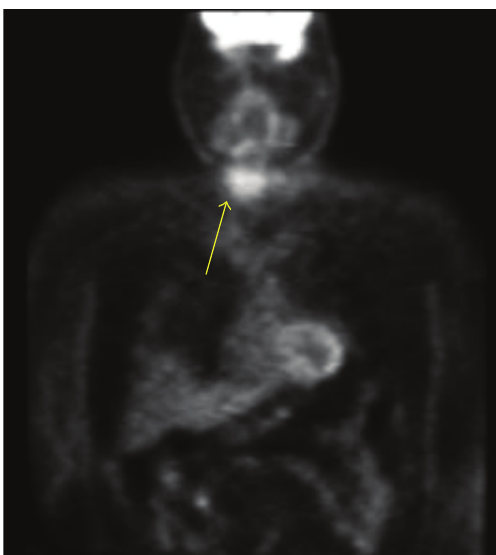
Figure 4: Nuclear Medicine Bone Scan: Confirms increased uptake of the